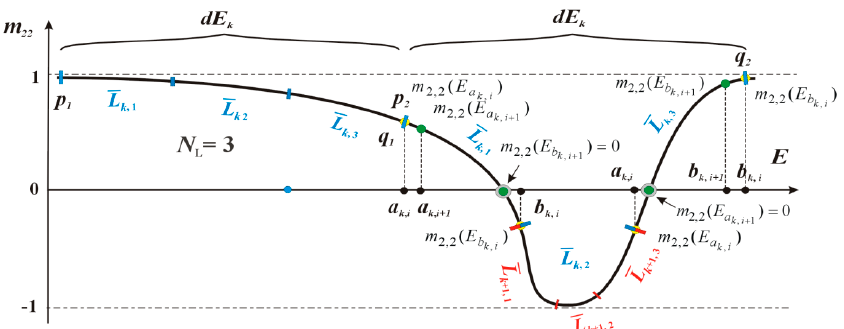
Figure 6. A schematic illustration of the new approach (MBM) to finding zeros of the m 2,2 ( E ) function. After dividing the interval < p 1 , q 1 >, into N L parts, all the sections are monotonic; hence, the procedure can take the next energy interval < p 2 , q 2 >. The non-monotonicity of the section L k ,2 triggers recursively its division into N L parts. After dividing the m 2,2 ( E ) function into monotonic sections, the sign at the ends of each section is checked and the procedure BM is started if signs are found to differ.